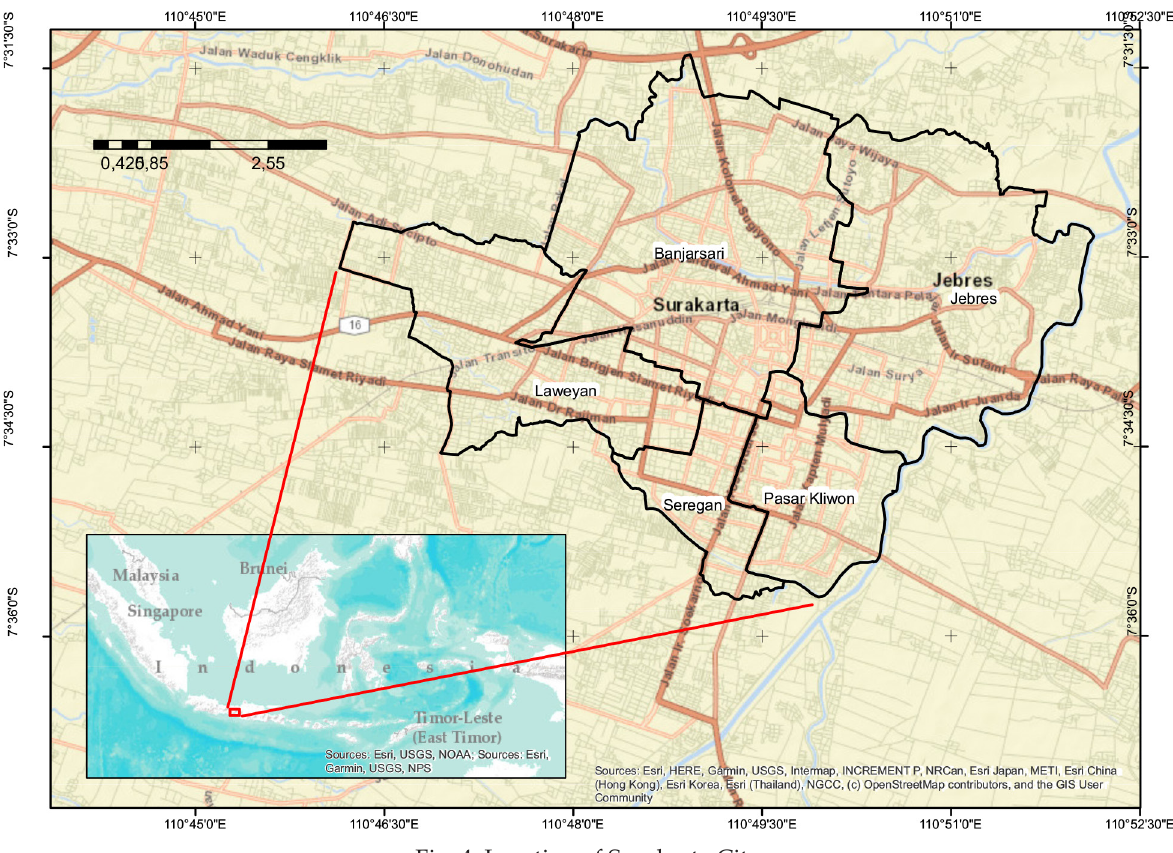
Fig. 4. location of Surakarta